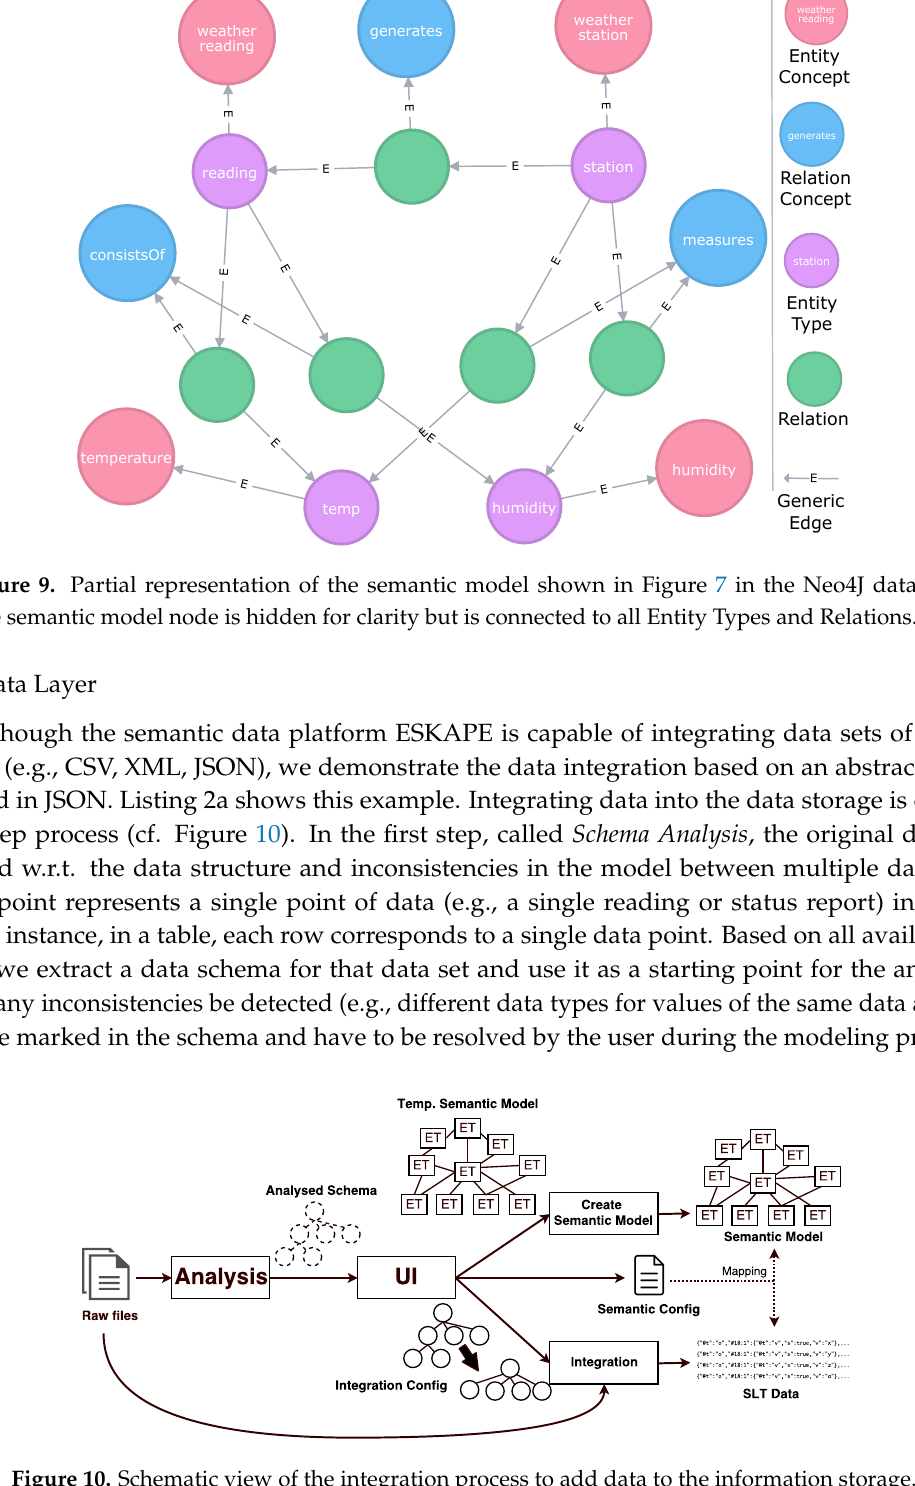
Figure 10. Schematic view of the integration process to add data to the information